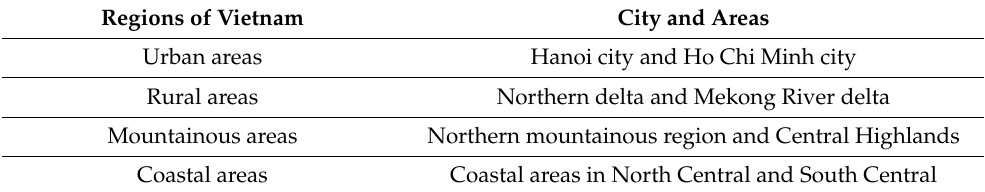
Table 1. Settings of the